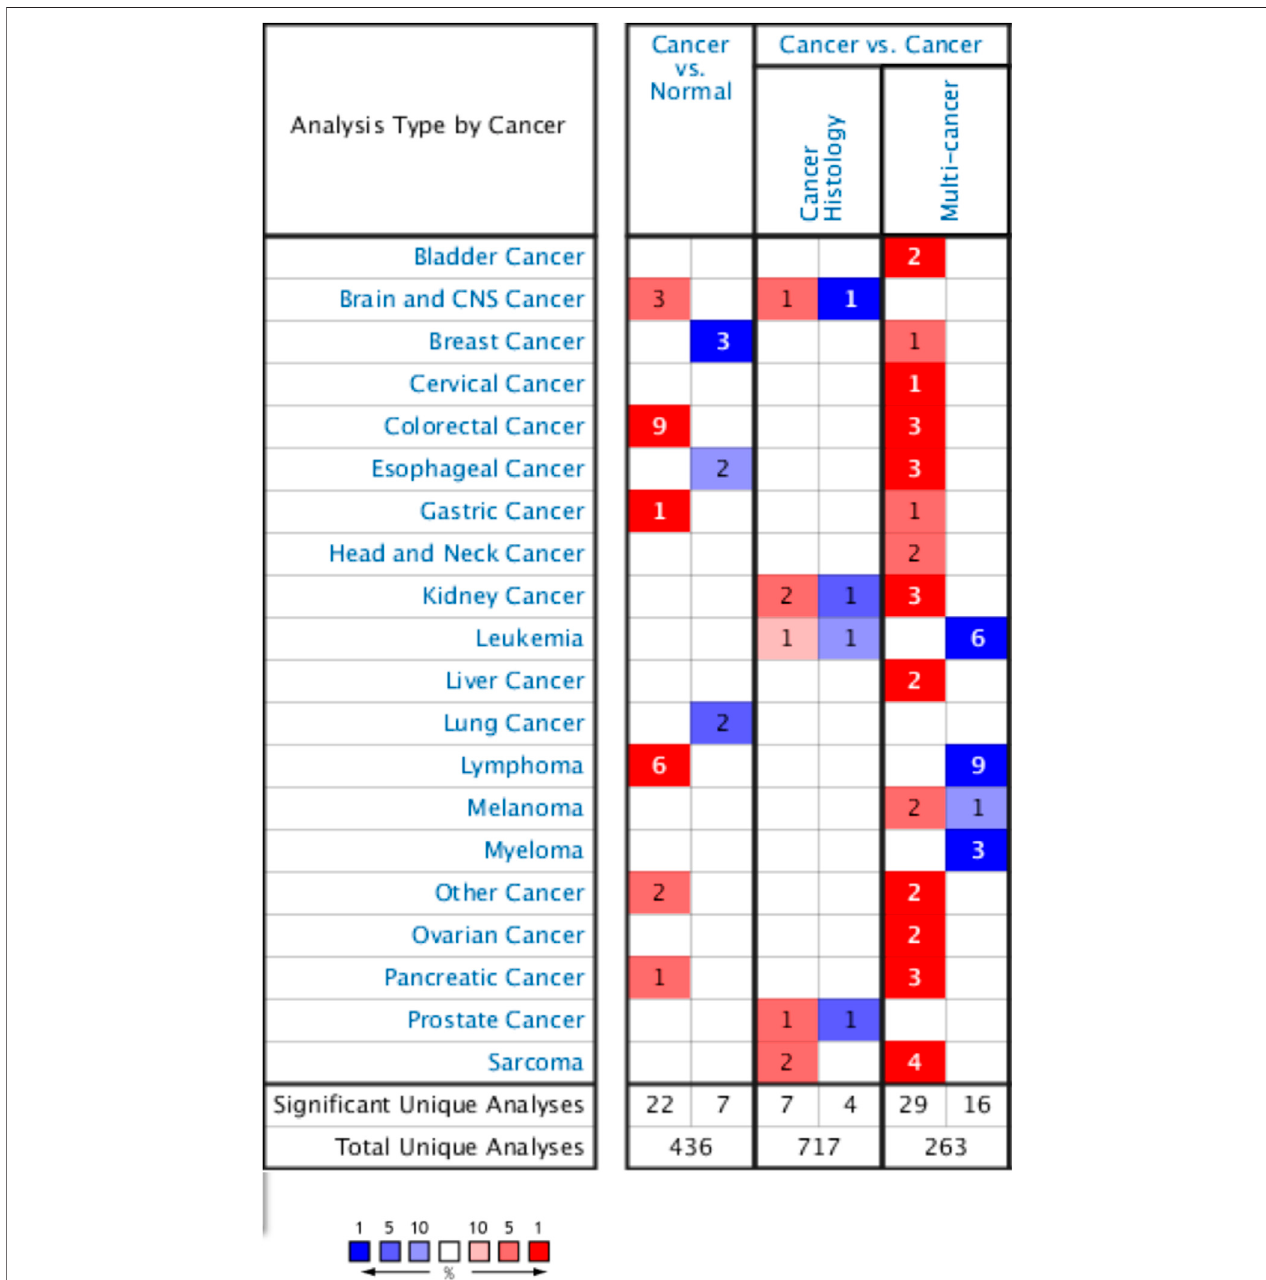
FIGURE 1 | Transcript levels of YAP1 in different cancers based on the ONCOMINE